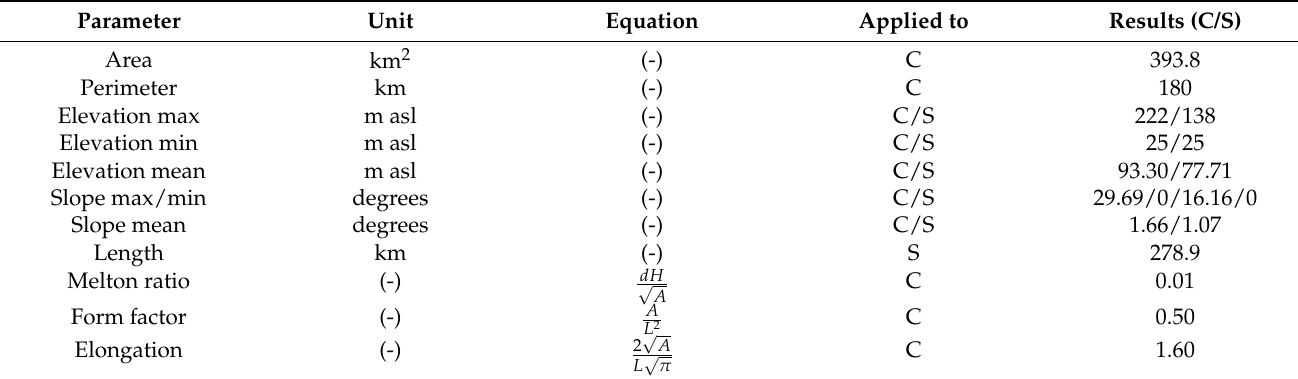
Table 1. Morphometrical parameters chosen for the Nonette catchment’s characterization with unit, the equation, if it is applied to the catchment or the stream and the results; C stands for catchment; S for stream. To be noted that « L » defined for the form factor corresponds to the length of the best-fitted ellipsoid calculated through the zonal geometry as table tool in the geographic information system